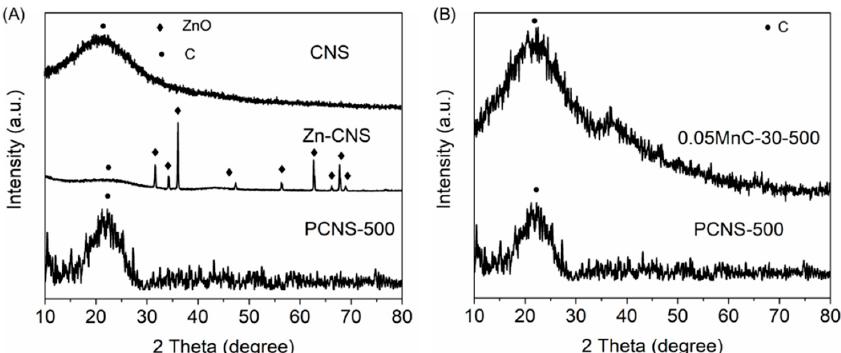
Figure 5. ( A ) XRD profiles of CNS, Zn-CNS, and PCNS-500; ( B ) XRD profiles of 0.05MnC-30-500 and PCNS − 500.